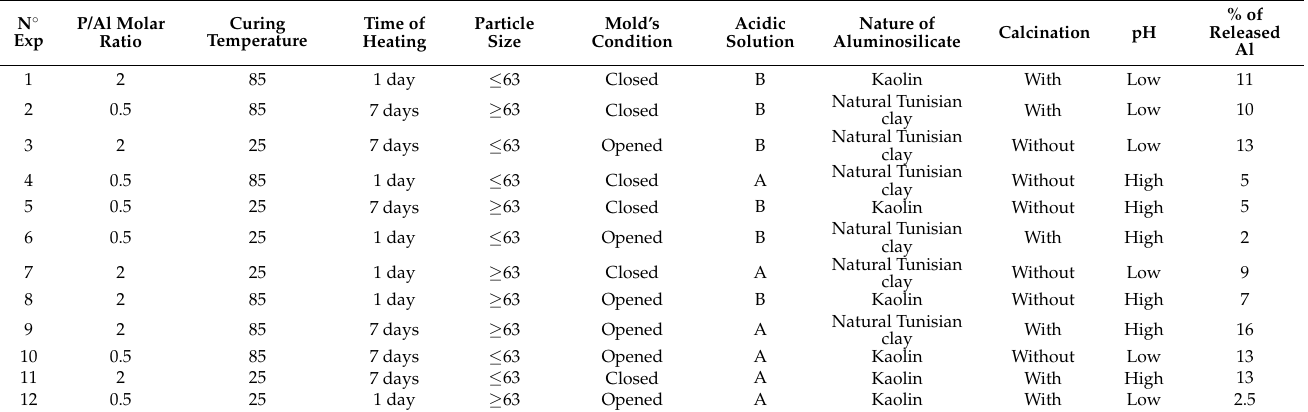
Table 6. Plackett–Burman experimental